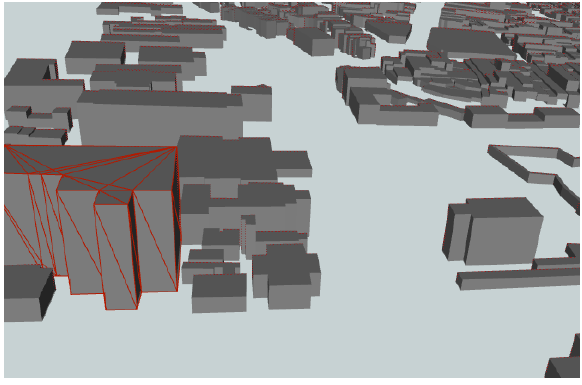
Figure 4. Extruded LoD1 Buildings from 3Dfier